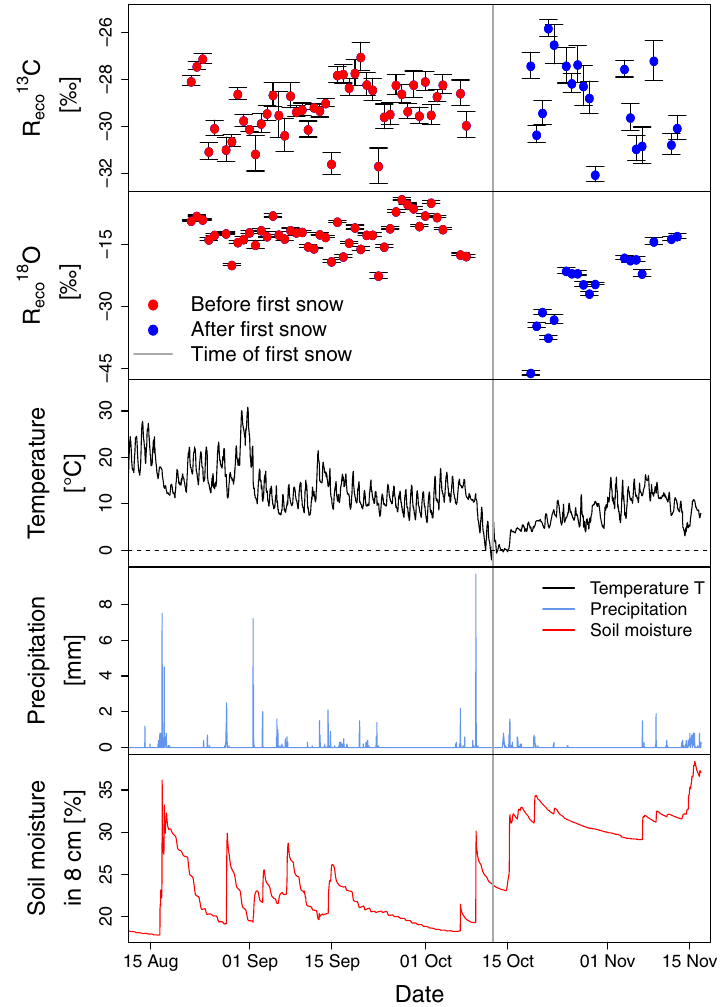
Figure 10. Time series of the measured isotopic composition of nighttime CO 2 exchange (respiration) R 13 eco C and R 18 eco O based on Keeling plot intercepts in combination with temperature, precipitation and soil moisture in 8cm depth. Error bars denote the standard error of the Keeling plot intercept (based on the linear regression of δ vs. 1/ c ). A particular feature of this time series is a first snow and frost event on 13 October 2015, marked in